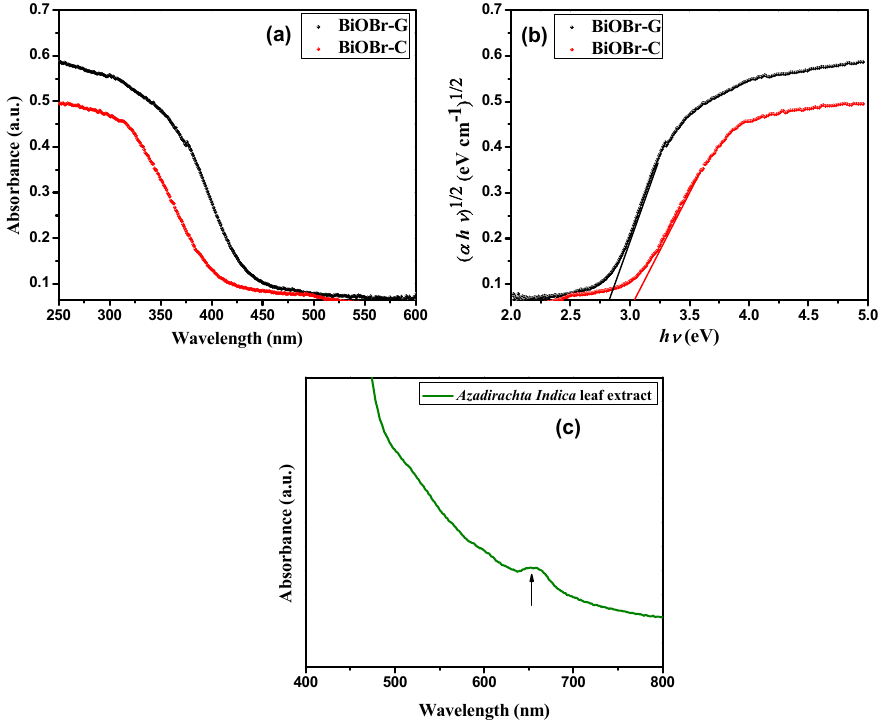
Figure 5. ( a ) UV ‐ vis diffuse reflection spectra, ( b ) Plot of ( α h υ ) 1/2 versus h υ of the BiOBr ‐ C and BiOBr ‐ G, and ( c ) UV ‐ vis absorption spectra of the raw Azadirachta indica leaf extract.